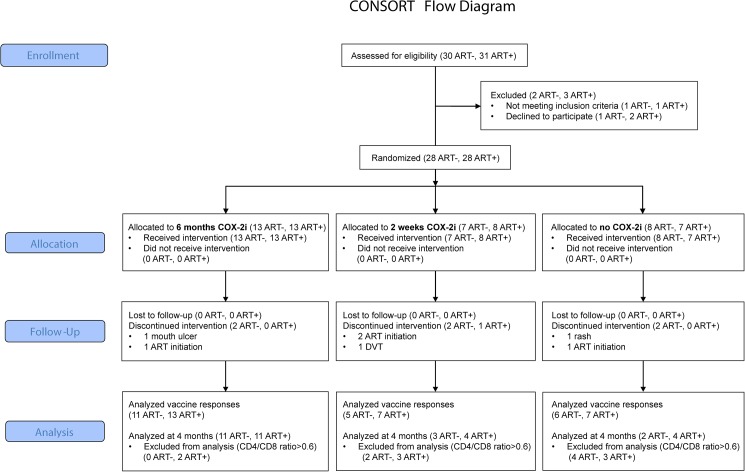
CONSORT flow chart.